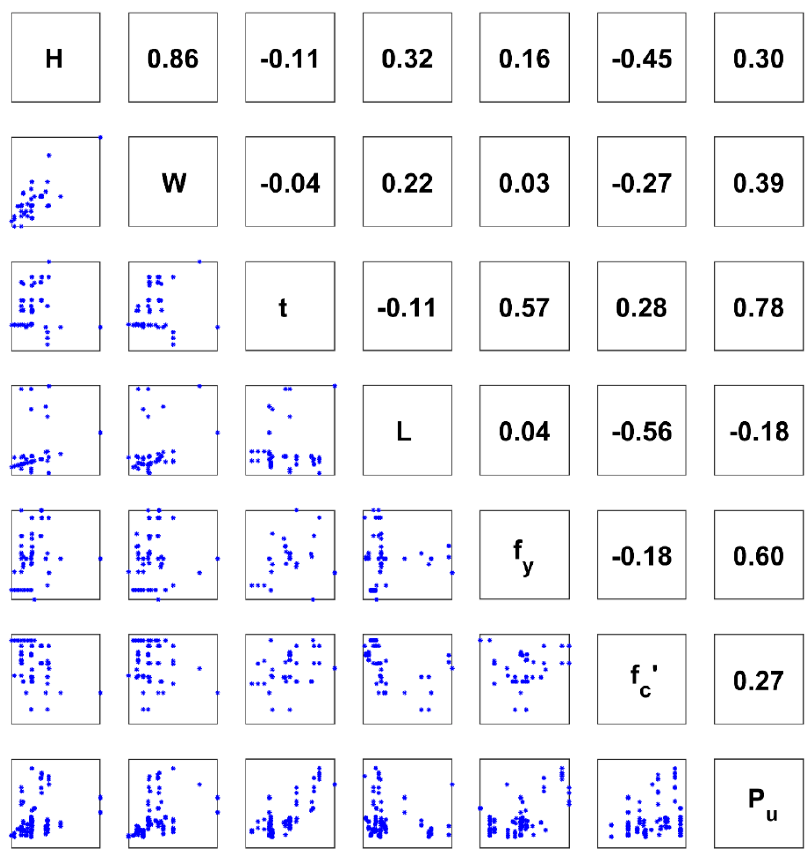
Figure 3. Correlation analysis between the depth of cross section (H), width of cross section (W), thickness of steel tube (t), length of column (L), yield stress of steel (f y ), concrete compressive strength (f c ’), and axial capacity (P u ).